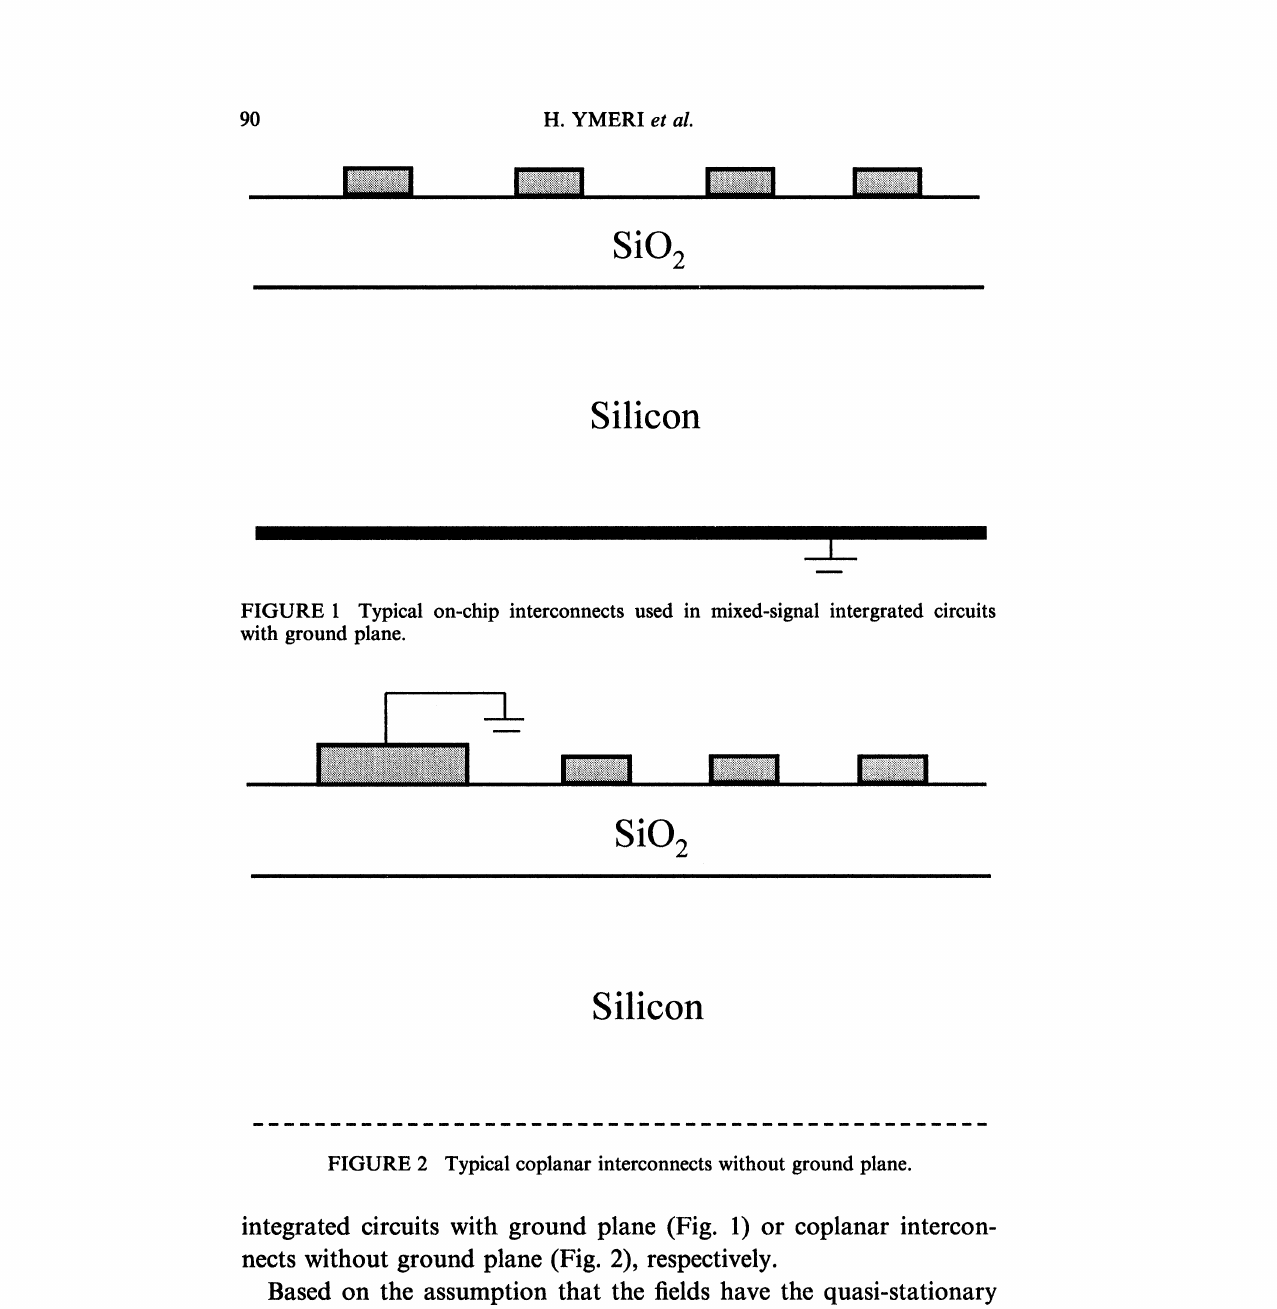
FIGURE 2 Typical coplanar interconnects without ground